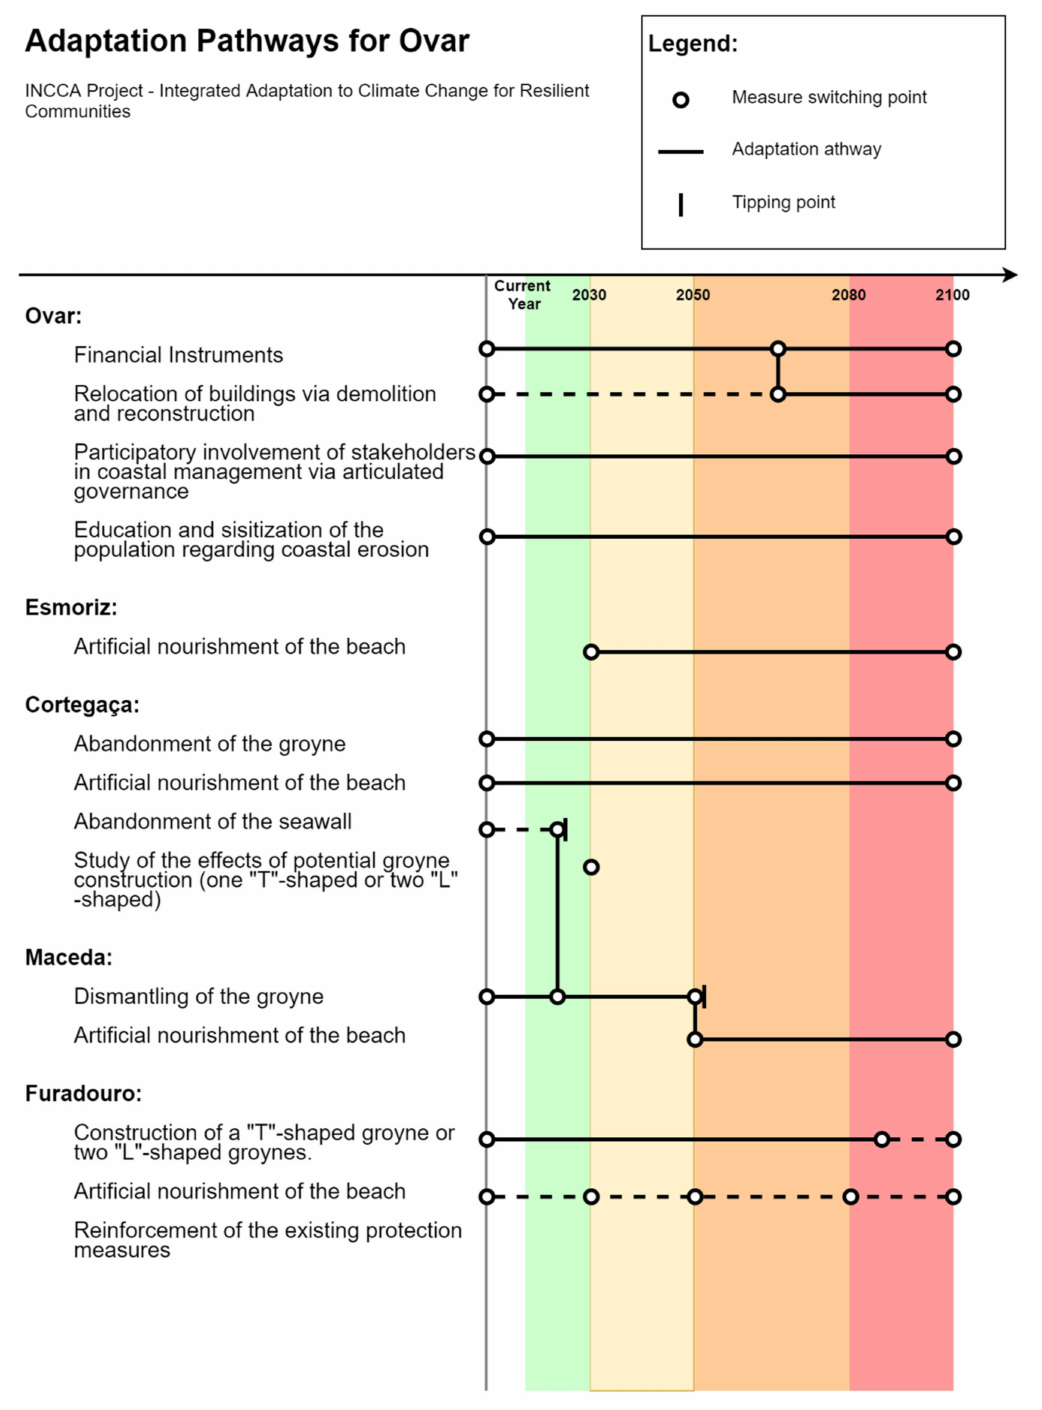
Figure 4. Final adaptation pathways map for the coast of Ovar. Full lines indicate planned measures, while dotted lines represent considered actions that may be taken if